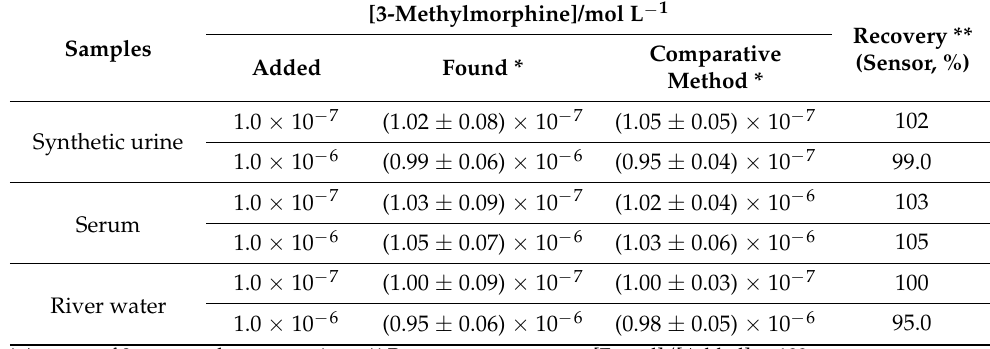
[3-Methylmorphine]/mol L − 1